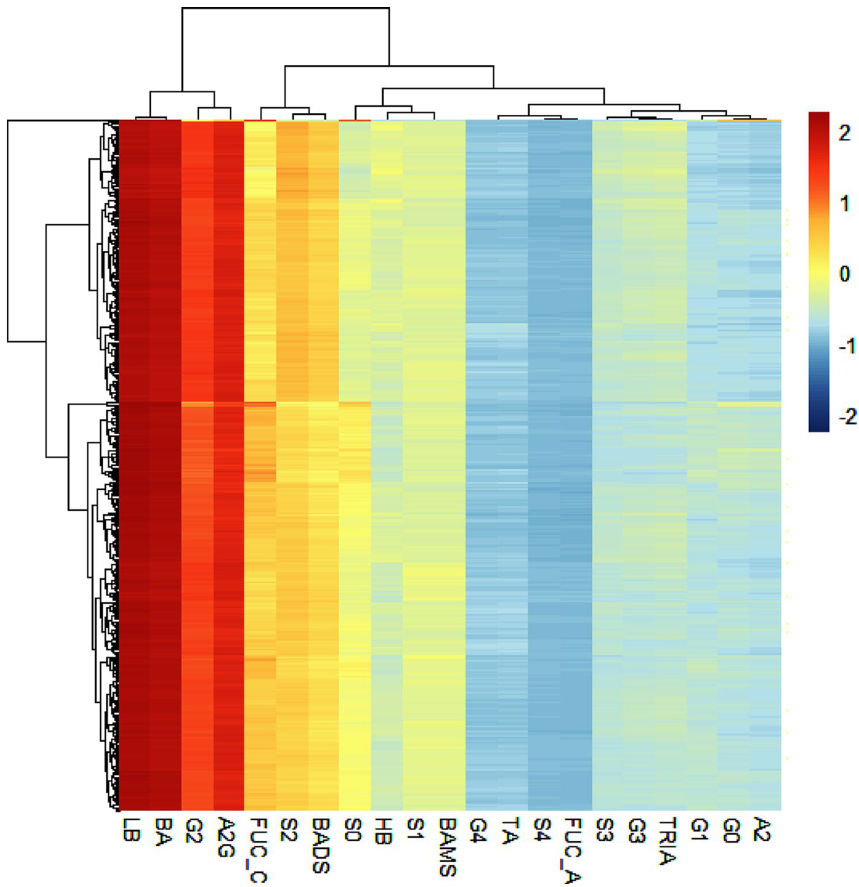
Figure 5. Hierarchical clustering of derived N-glycans traits in cases and controls. Hierarchical clustering of the cases and control samples using the measurement of sugars and lipids from block sPLSDA-reg network. Agglomerative hierarchical clustering was derived using the Euclidean distance as the similarity measure and Ward methodology. The red colour indicates that the row-column clusters are positively correlated, and the light blue colour indicates a negative correlation, whereas yellow indicate weaker correlation